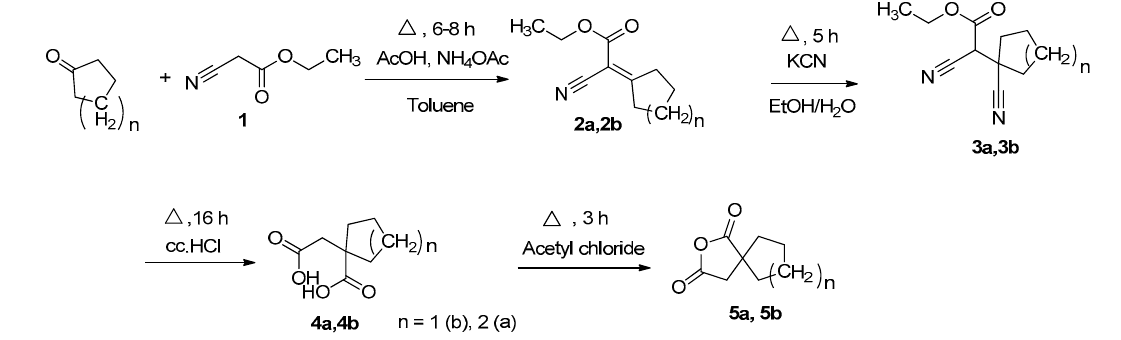
5 Figure 4. Biologically active pyridazinones. 2. Synthesis of Spiro[cycloalkane-pyridazinone] Derivatives Taking into account the expected bioactivity of the pyridazine derivatives and their favorable physicochemical parameters, our attention turned to this family of compounds. Considering the advantages of compounds with high Fsp 3 character, we have designed a compound library with a spiro[cycloalkane-pyridazinone] scaffold instead of the usual phenyl-pyridazinone derivatives. 2.1. Synthesis of the Starting Materials The